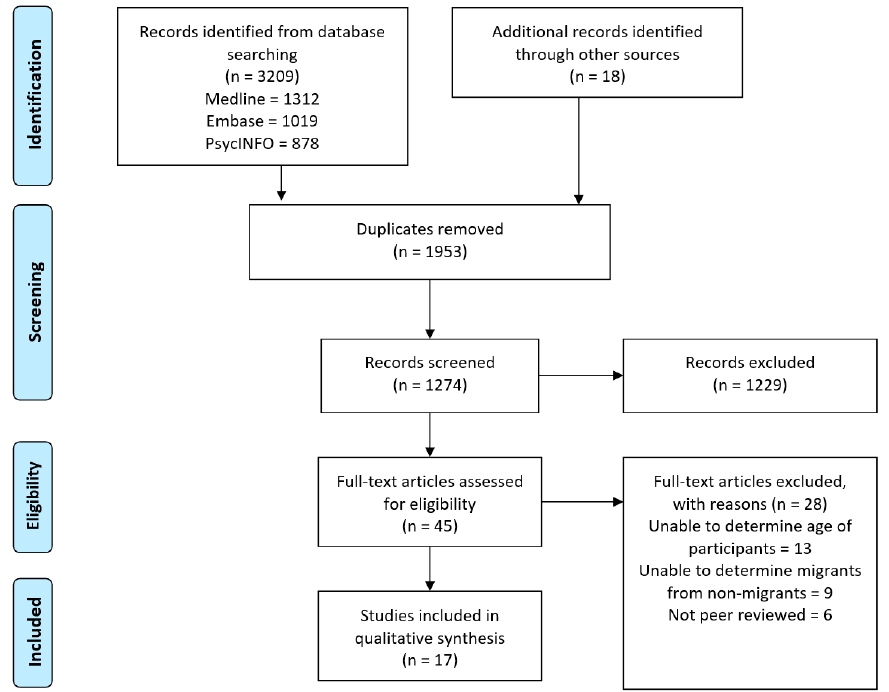
Figure 1. Results of PRISMA flow diagram.